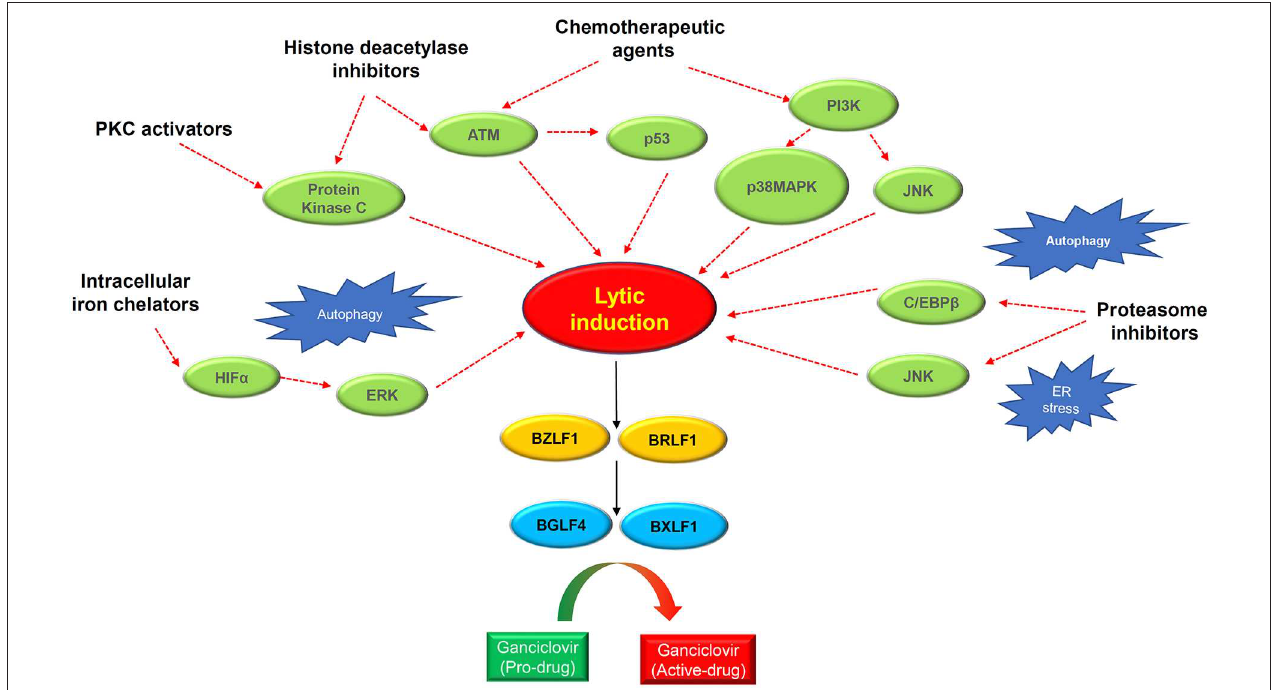
FIGURE 4 | Schematic diagram showing the rationales of lytic induction treatment of EBV-associated cancers. Multiple classes of chemical inducer trigger EBV lytic induction via activating different cellular signaling pathways with extensive cross-talks. Histone deacetylase inhibitors and protein kinase C (PKC) activators induce the PKCdelta and ATM signaling pathway. Chemotherapeutic agents activate the ATM-p53 signaling axis as well as the PI3K/p38MAPK/JNK signaling. Proteasome inhibitors trigger autophagy and ER stress which induce EBV reactivation via activating JNK and C/EBP β . The intracellular iron chelators induce hypoxia via HIF α and ERK activation, causing EBV lytic induction. Through inducing the IE genes BZLF1 and BRLF1 , the chemical inducers switch on EBV lytic cycle. The expression of IE proteins further induces the early lytic proteins BGLF4 (protein kinase) and BXLF1 (thymidine kinase) which convert the ganciclovir into cytotoxic drugs to kill cancer cells during the cytolytic